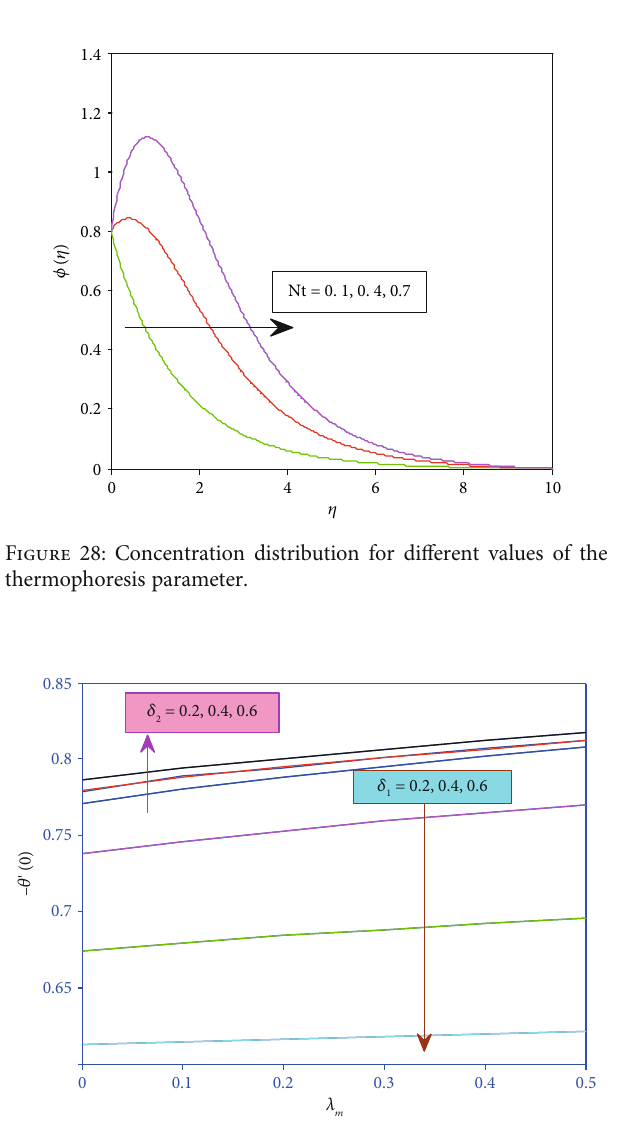
Figure 29: E ff ects of thermal and solutant strati fi cation parameters on the heat transfer rate.